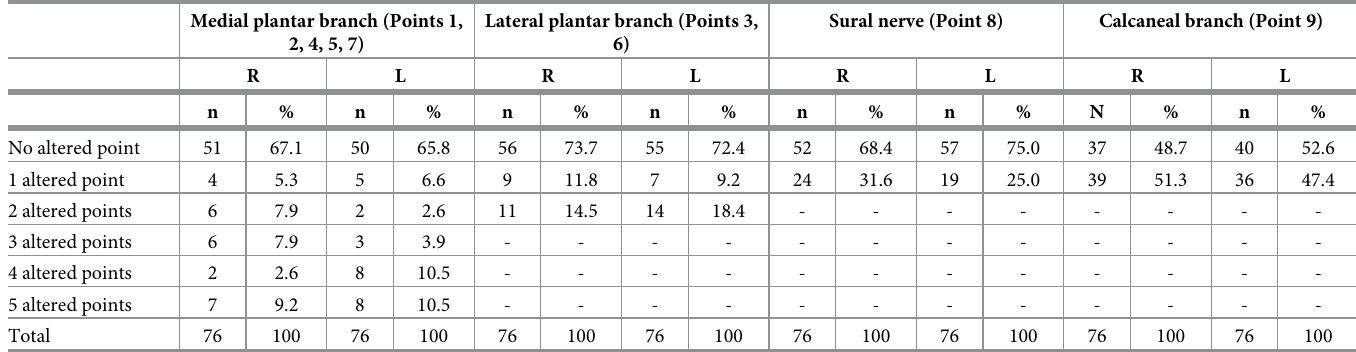
Table 10. Distribution of the number of SWM-test (normal and altered) points of the feet per patient at the end of the treatment and corresponding nerves. Medial plantar branch (Points 1, 2, 4, 5, 7)